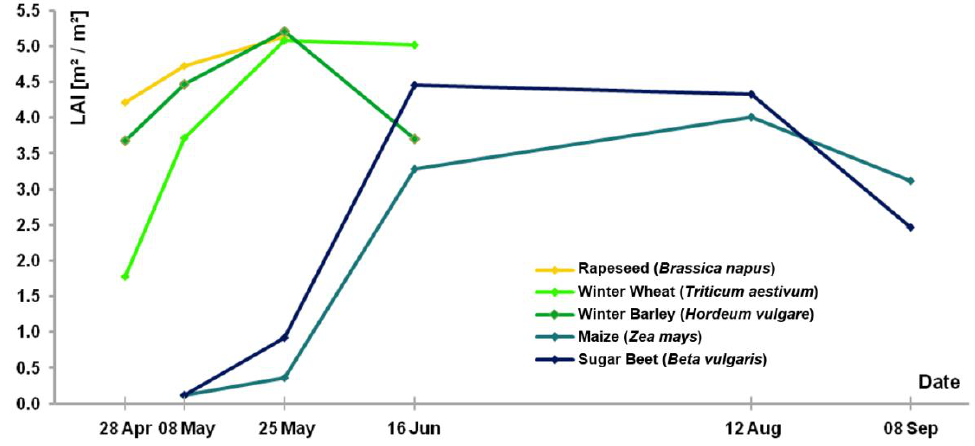
Figure 6. Seasonal development of LAI for the five investigated crops throughout the growing period of 2012, derived from six data